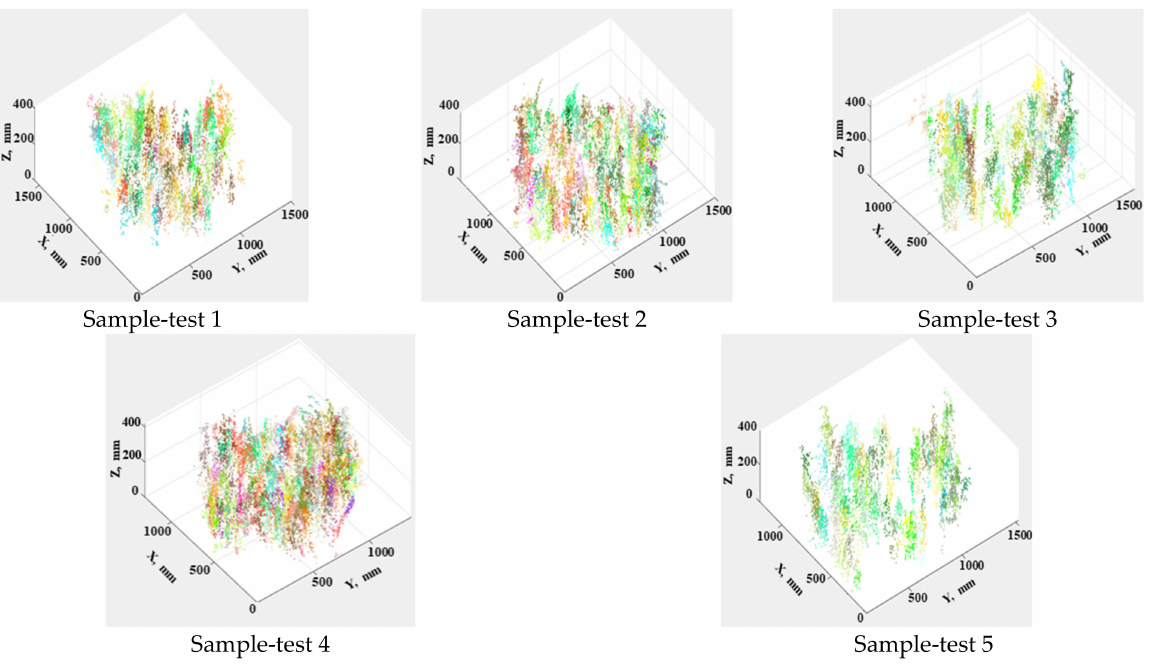
Figure 12. Mean-shift clustering results of random experiment group. The rice-density-estimation methods calculated by supervoxel clustering and mean- shift clustering based on adaptive-parameter adjustment were verified by random experi- ment group. Matlab and the Point Cloud Library (PCL) point-cloud database were used in the experiment. According to the relationship between the size of seed points and the number of points, the supervoxel algorithm adaptively sets the seed-point spacing. The mean-shift algorithm sets the kernel bandwidth according to the relationship between the kernel bandwidth and the number of points.